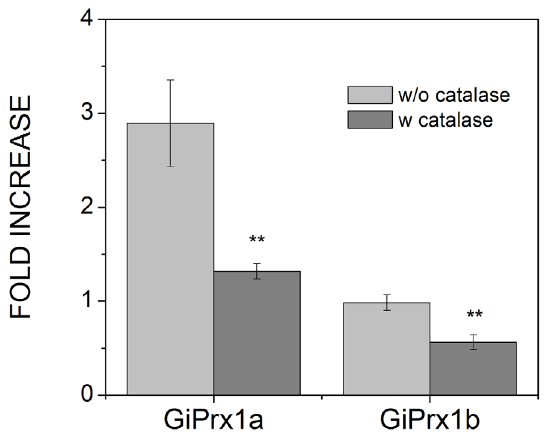
Figure 7. Effect of exogenous catalase on the transcriptional levels of Gi Prxs. Transcriptional levels of Gi Prx1a and Gi Prx1b measured in parasitic cells after 24 h-incubation with air, in the presence or absence of 120 U mL 2 1 catalase (mean 6 1 SEM, n $ 4). Data were normalized to the mRNA levels of the ribosomal small subunit protein S26 (ORF 17364), and expressed as the ratio to the expression levels detected in trophozoites grown under anaerobiosis for 24 h. **P ,